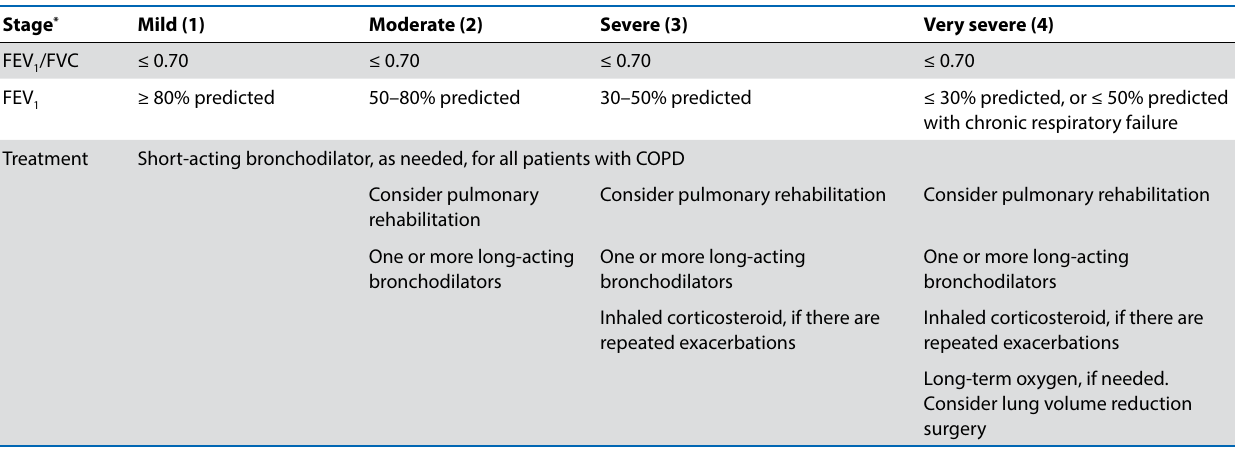
Table 1: The Global Initiative for Chronic Obstructive Lung Disease guideline for the treatment of chronic obstructive pulmonary disease Stage